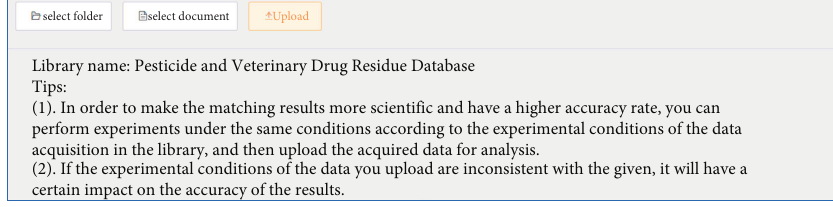
Figure 1: File upload page. The file upload page contains the library name and tips.